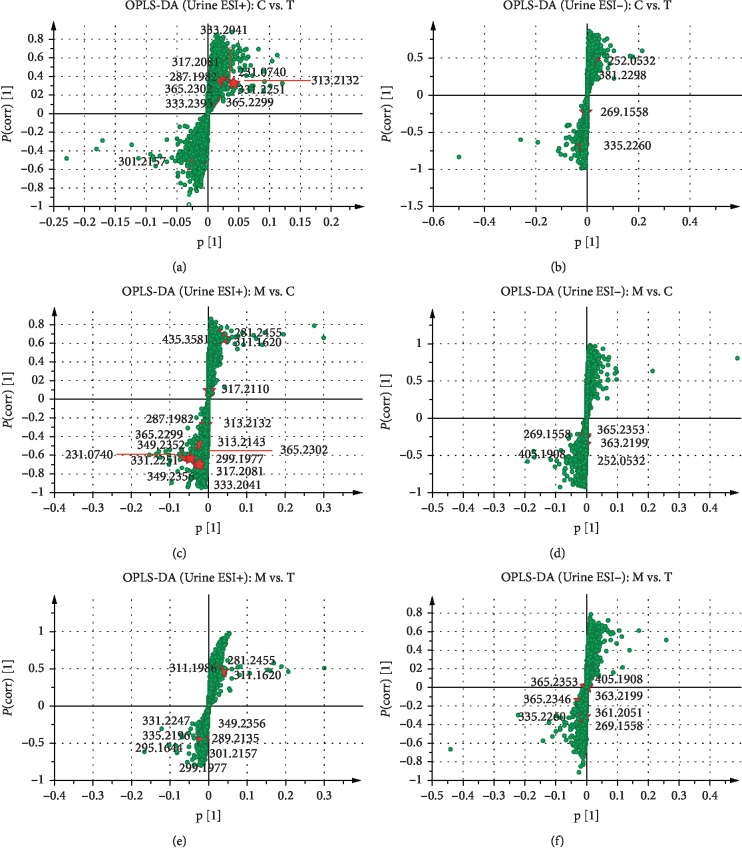
OPLS-DA S-plots of metabolomics analysis based on urine samples. All differential metabolites are shown in S-plots, including the identified results between the control group and the RWCI treatment groups in the ESI+ mode (a) and in the ESI− mode (b), the identified results between the model group and the control group in the ESI+ mode (c) and in the ESI− mode (d), and the identified results between the model group and the RWCI treatment groups in the ESI+ mode (e) and in the ESI− mode (f). C: control group; M: model group; T: RWCI treatment groups. The p(corr)[1]-axis shows the reliability of each variable in X.